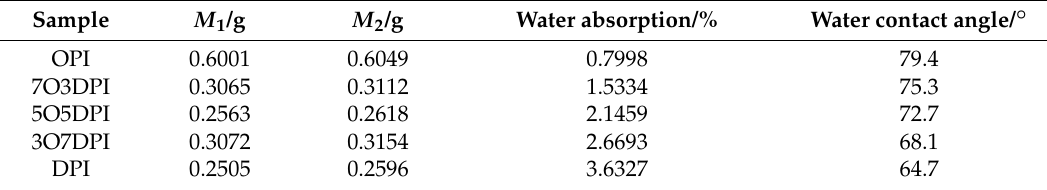
Table 2. Water absorption and water contact angle of the polyimide